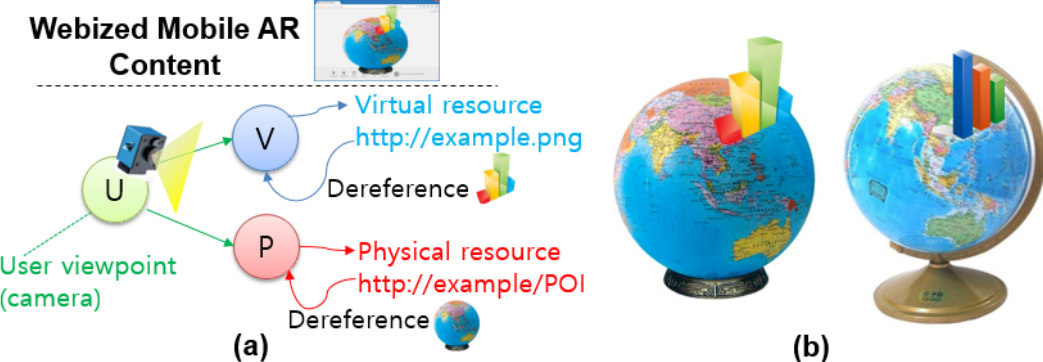
Figure 7. Webized augmented reality (AR) content representation in which virtual data are associated with a Web-accessible physical resource [37]: ( a ) virtual and physical resources of webized AR content, and ( b ) an example associating a physical sensor dataset [38].